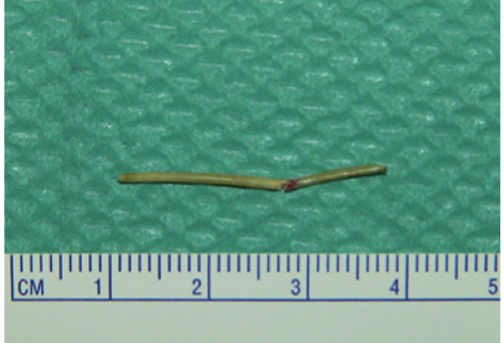
Figure 3: Gross examination revealed one linear, solid, and white- yellow structure, compatible with fish